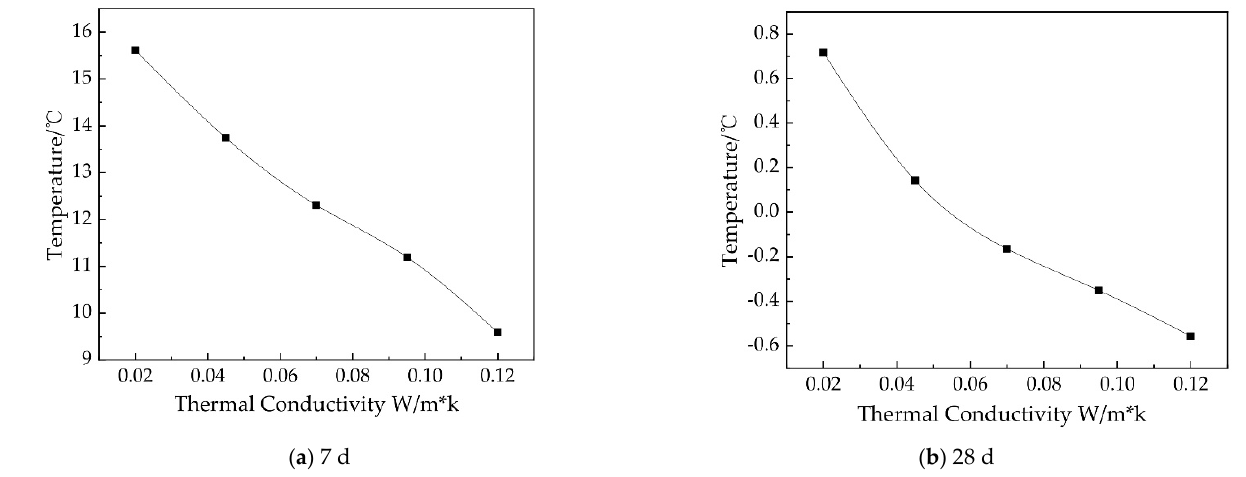
Figure 12. Temperature change of pile foundation at 7.4 m.